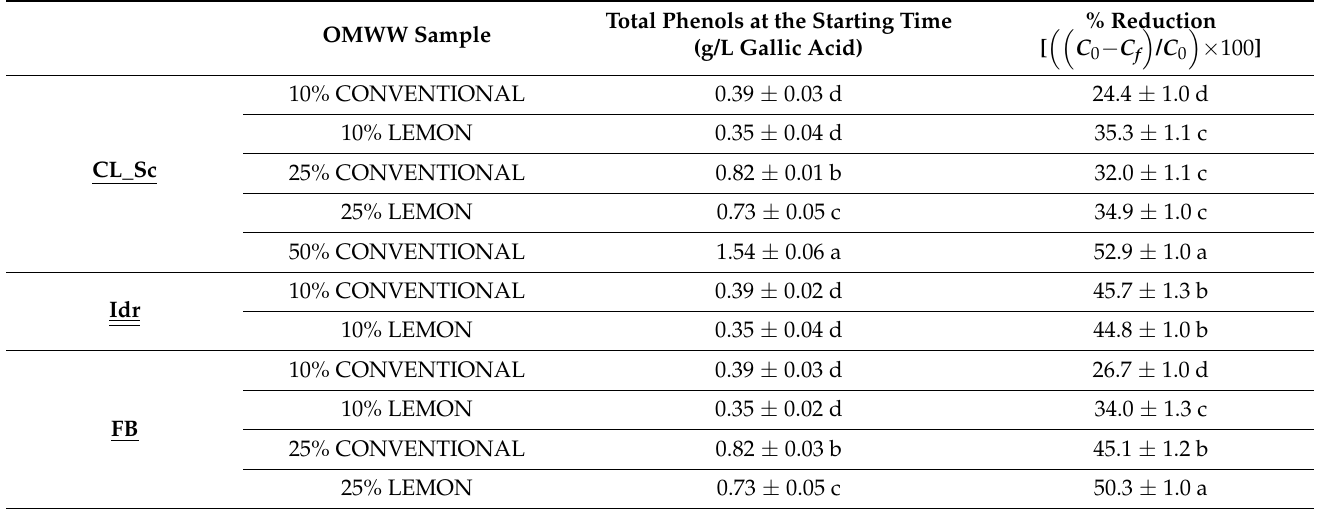
Table 3. Total phenols at the starting time and their percentage reduction after one-week experiment in the second experiment performed on the best microalgae strains (only the best data are reported). Total Phenols at the Starting Time % OMWW Sample (g/L Gallic Acid)